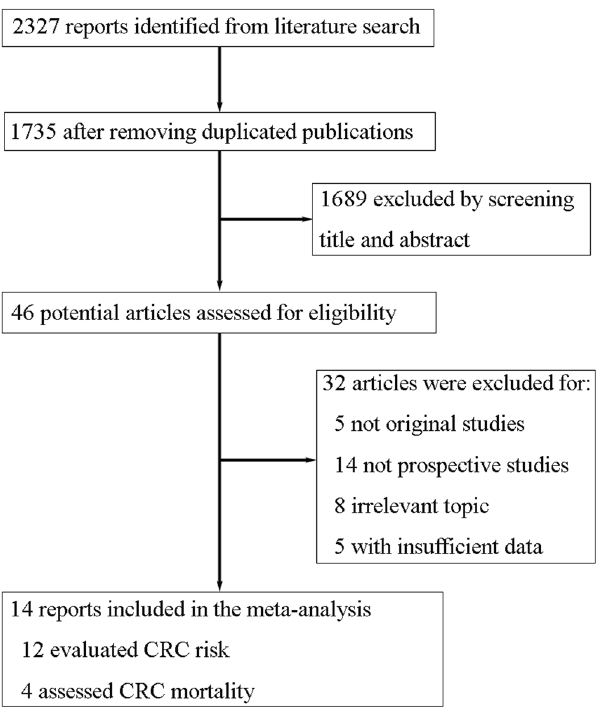
Figure 1. Flow diagram of studies through the retrieval and inclusion process in the meta-analysis. Two studies assessed both risk and mortality of